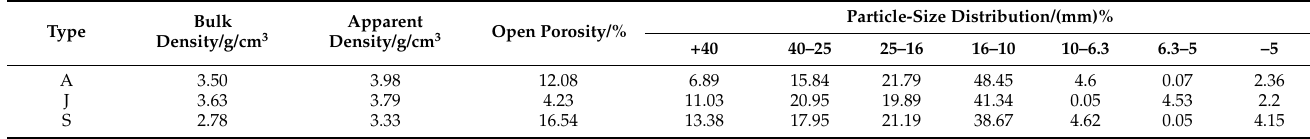
Table 2. Physical properties of three types of natural lump